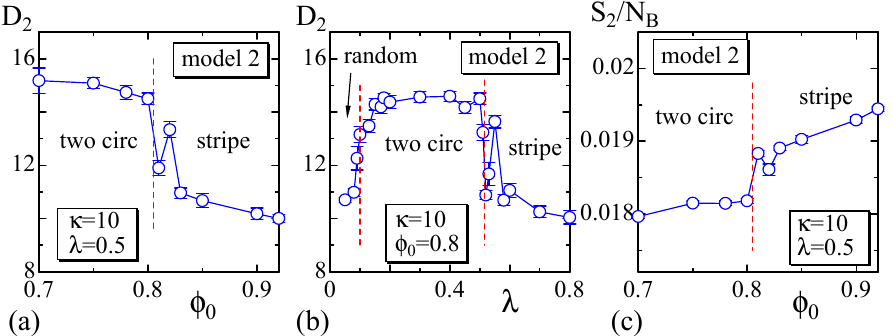
Figure 7. ( a ) The size D 2 vs. φ 0 at λ = 0.5; ( b ) D 2 vs. λ at φ 0 = 0.8; and ( c ) the bending energy S 2 / N B vs. φ λ = 0.5. These are calculated on the dashed horizontal and vertical lines in Figure 6. The size of 0 at the surface changes almost discontinuously and smoothly at the phase boundaries, which are denoted by the dashed